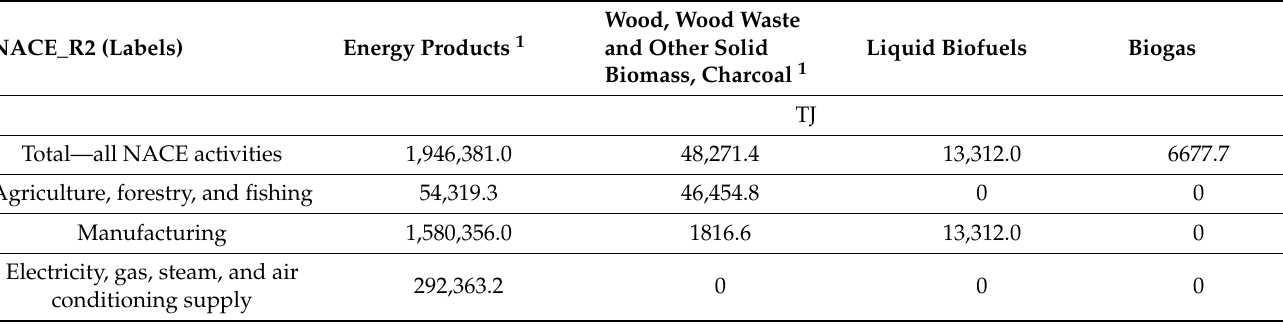
Table 3. The supply and use of energy in 2019 according to NACE data (Nomenclature des Activities Économiques dans la Communauté Européenne)—the European industry standard classification system [TJ].